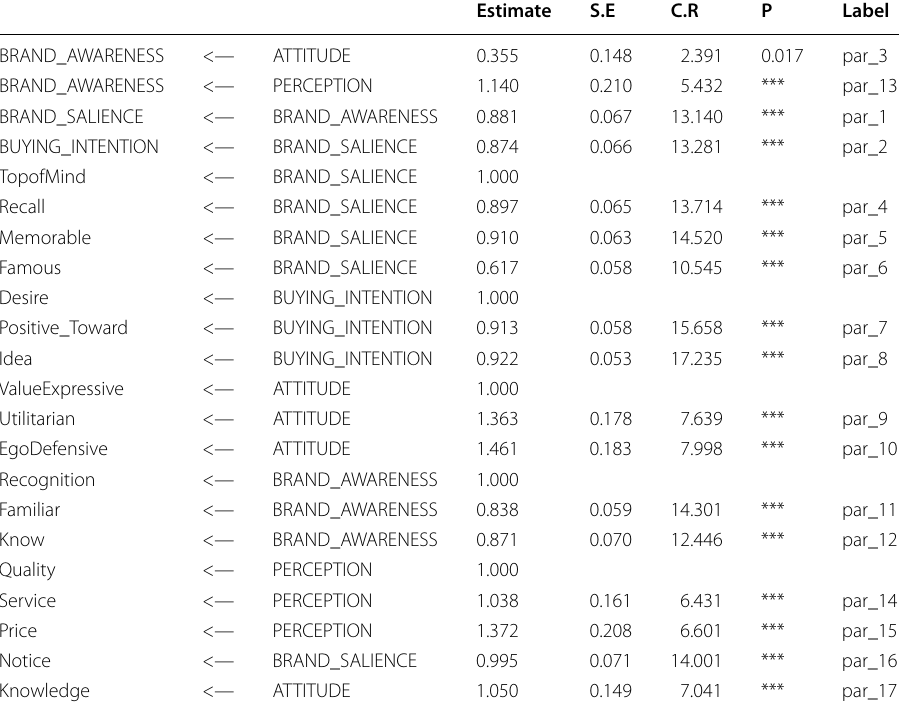
***Significant at level 1%